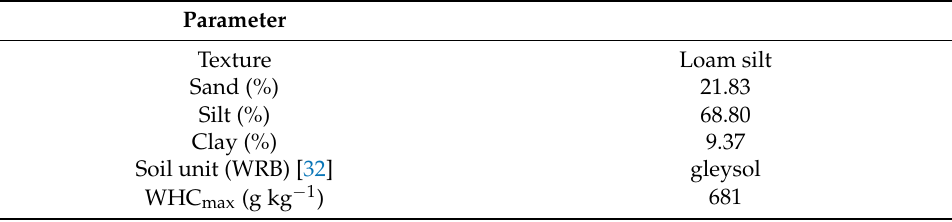
Figure 1. Impressions from the study sites of the riparian area during the vegetation season in August 2020 and the investigated stands ( a ) Impatiens glandulifera stand, ( b ) Urtica dioica stand, ( c ) satellite image from the respective site: shorturl.at/bpRT7 (accessed on 9 August 2022). Table 1. Determined selected physico-chemical parameters of the investigated soil (dry mass